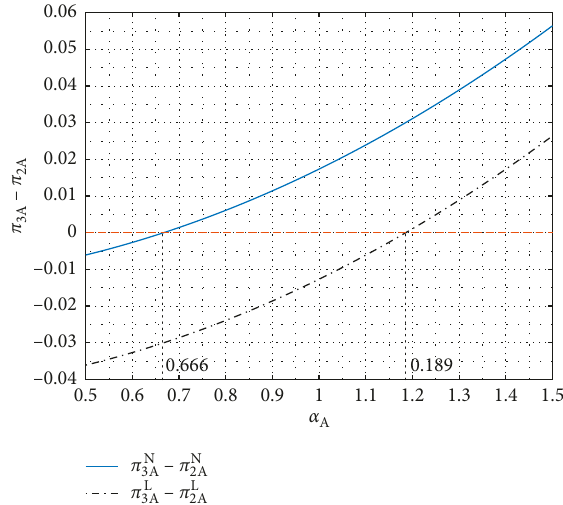
Figure 13: Impact of subsidy on manufacturer A.